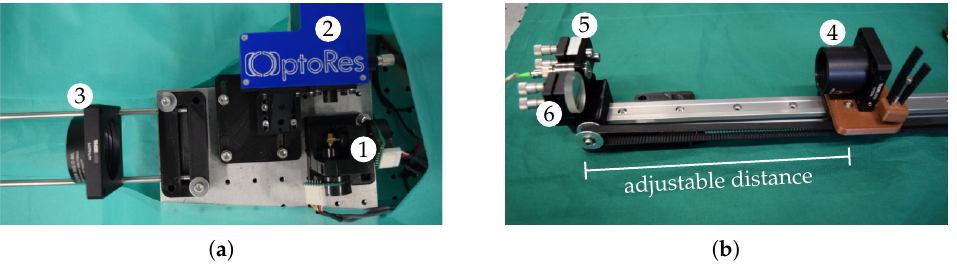
Figure 2. The OCT’s FOV can be shifted laterally by a second pair of galvos ( a , 1) in front of the actual scan head ( a , 2) and the range is limited by the achromatic lens with diameter of 50.8mm ( a , 3). For axial shifting, a retroreflector ( b , 4) is mounted to a motor. Due to the setup with the collimator ( b , 5) and the mirror ( b , 6), the path length of the reference arm varies as twice the traveling distance of the